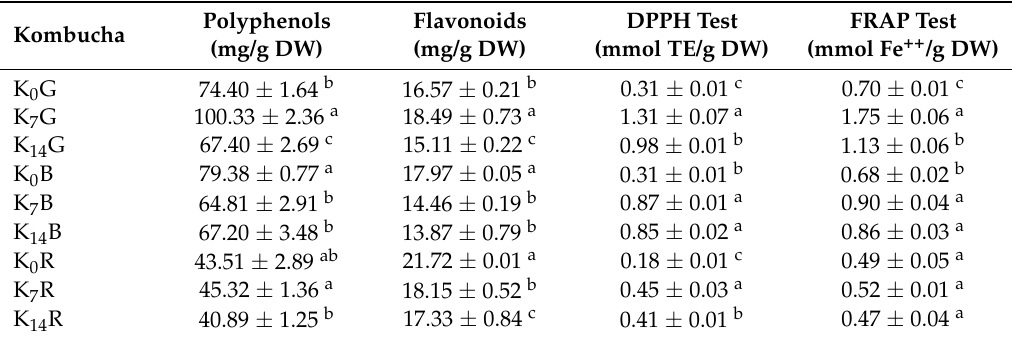
Table 5. Polyphenols and flavonoids content and antioxidant activity of kombuchas 0, 7, and 14 days of fermentation. Kombucha